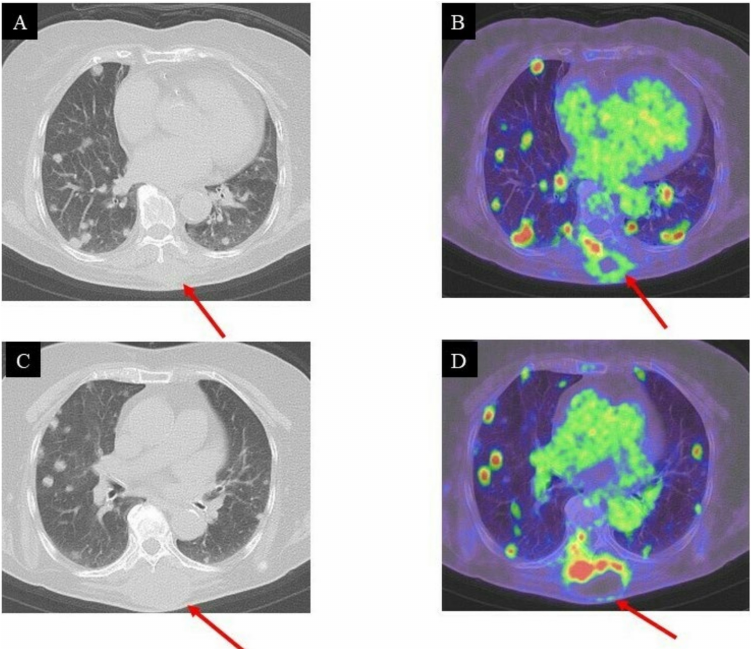
Figure 5. CT and PET/CT images of the lung three months after surgical resection: local recurrence and multiple pulmonary metastases; ( A , B ), ( C , D ): high FDG uptake in the intrinsic back musculature (SUV max = 14.96) and bilateral lung lesions (SUV max = 7.15–16.22),